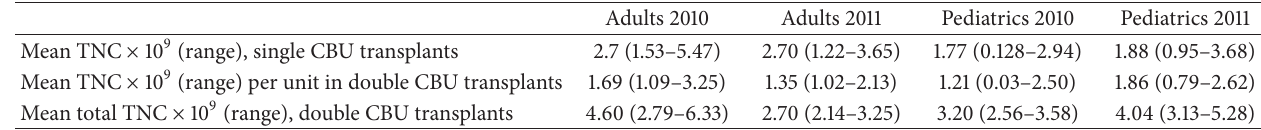
Table 2: TNC counts on umbilical cord blood units utilized in Canada